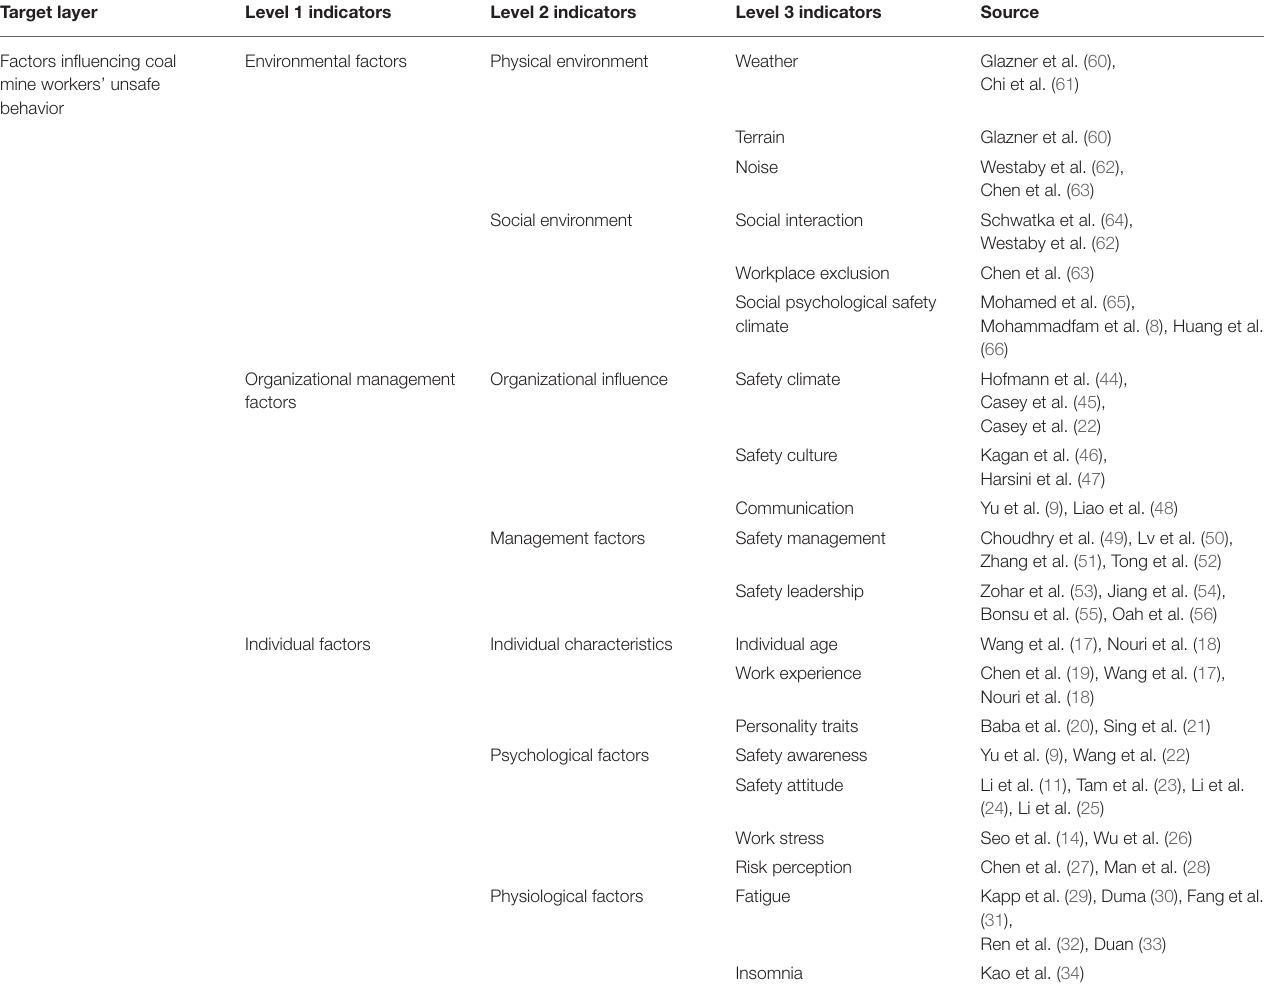
TABLE 6 | Index system of influencing factors of coal mine workers’ unsafe